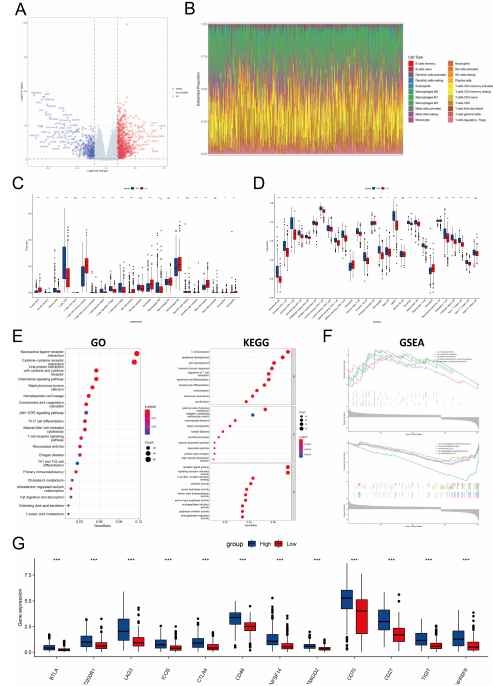
Figure 8. Bioinformatic analysis of two PYCARD subgroups in the KIRC cohort. ( A ) The DEGs between the high-PYCARD group and the low-PYCARD group are presented in the volcano plot. ( B ) The proportions of immune cells using the CIBERSORT method. ( C ) Difference of immune cell proportions between PYCARD subgroups. ( D ) Difference of single sample GSEA (ssGSEA) in immune cell proportions between PYCARD subgroups. ( E ) Gene ontology and KEGG pathway analysis of DEGs between PYCARD subgroups. ( F ) GSEA analysis of DEGs between PYCARD subgroups ( G ) Expressions of ICP genes varied in PYCARD subgroups (*** p < 0.001). (DEG, differentially expressed genes; GO, gene ontology; GSEA, gene set enrichment analysis; ICP, immune